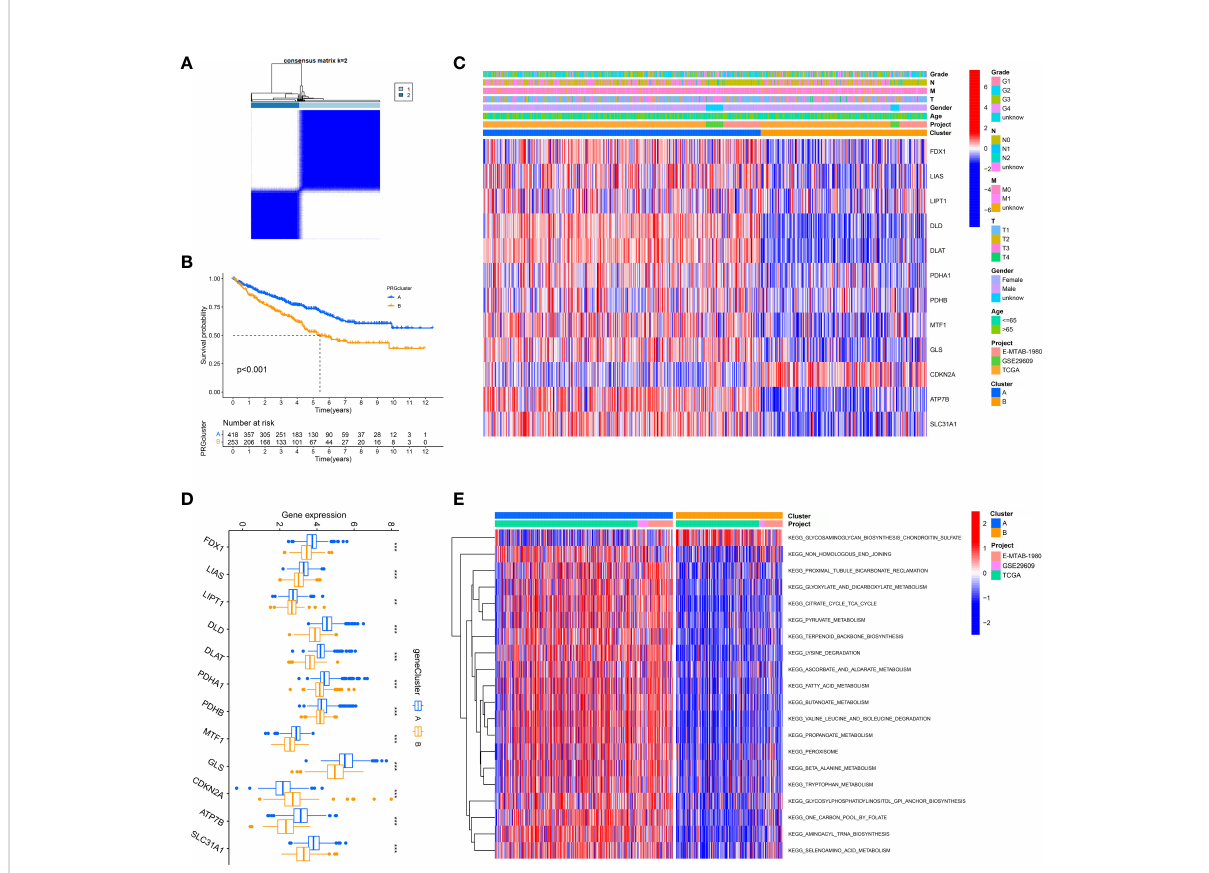
FIGURE 2 Unsupervised learning for cuproptosis classi fi cation. (A) Unsupervised clustering of 12 cuproptosis genes and the optimized consensus matrix with k = 2. (B) Kaplan-Meier Curves for differential survival of two cuproptosis phenotypes in the merge cohort which contains three datasets: TCGA, GEO, and E-MTAB-1980. (C) Heat map of clinical characteristics of two cuproptosis phenotypes. (D) Variable expression of cuproptosis genes in two phenotypes. (E) Heat map of the activation state of the top 20 KEGG pathways in different phenotypes. ** P < 0.01, *** P <